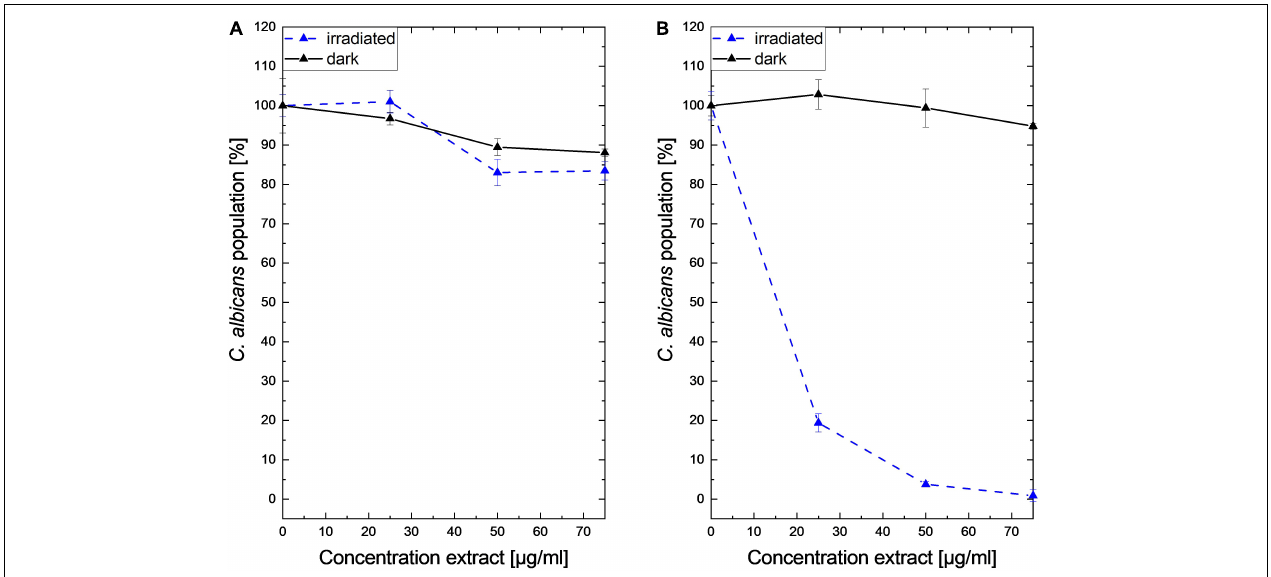
FIGURE 10 | Dose–response curves of C. albicans treated with a Cortinarius xanthophyllus extract in the dark (black solid plot) and under blue light irradiation (blue dashed plots, λ = 478 nm, H = 30 J/cm 2 ). On the left side (A) , the results with a preincubation time of t = 10 min are shown. The right graph (B) shows the growth inhibition after a preincubation time of t = 60